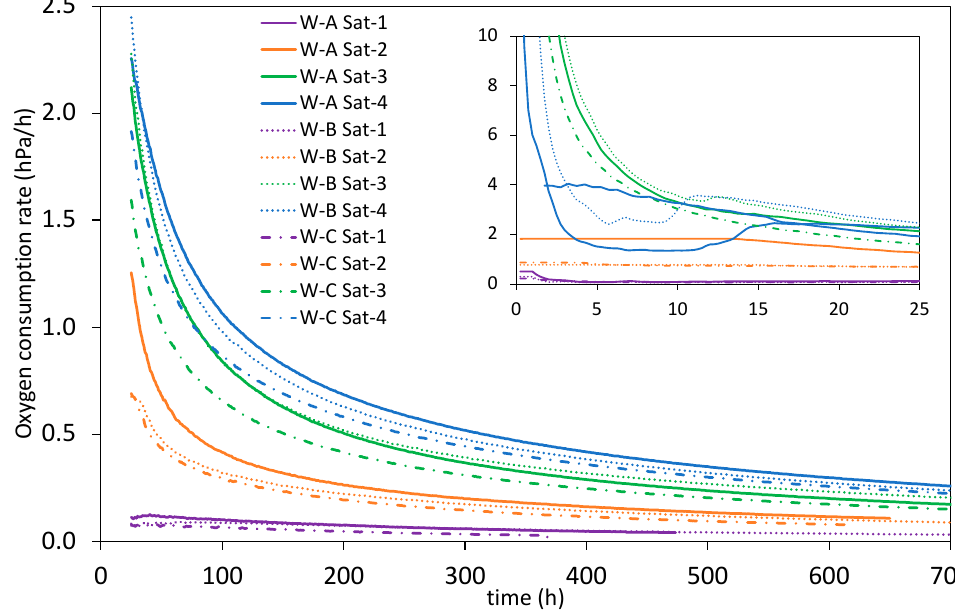
Figure 3. Oxygen consumption rate (Sat-1: purple, Sat-2: orange, Sat-3: green, and Sat-4:blue). Table 1b shows that for all three Ws the initial consumption rate was higher in the samples with higher oxygen levels (Sat-3 and Sat-4). When samples were saturated with oxygen levels equal to or lower than air, their consumption rate was significantly lower (Figure 3), with a maximum oxygen consumption of 2 hPa/h (0.1 mg/L · h) observed in W-A during the first 15 h. When samples were saturated with oxygen levels lower than what was present in air, oxygen was consumed very slowly (below 0.15 hPa/h in the first few hours, zoom Figure 3) and after 15 days the rate of oxygen consumption stabilized at 0.05 hPa/h (0.002 mg/L · h) in all samples analyzed, regardless of their nature. In the case of saturating the samples with the Sat-4 level, in the first 3 h the consumption rate dropped below 0.23 mg/L · h (5 hPa/h), while the samples with Sat-3 level needed twice as long (7 h) to reach the same consumption rate of 5 hPa/h (Figure 3).